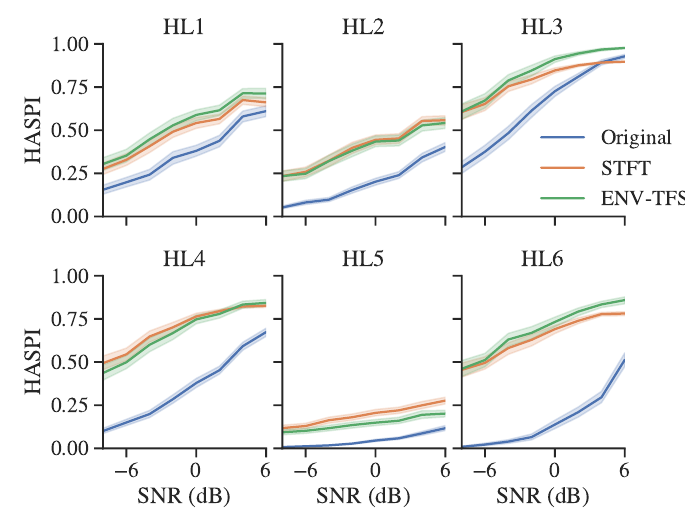
Figure 5. Illustrated comparison of HASPI scores between the proposed (ENV-TFS) and conventional (STFT) speech enhancement systems across di ff erent SNR values (from − 8 to 6 dB) for the HL1–6 simulated